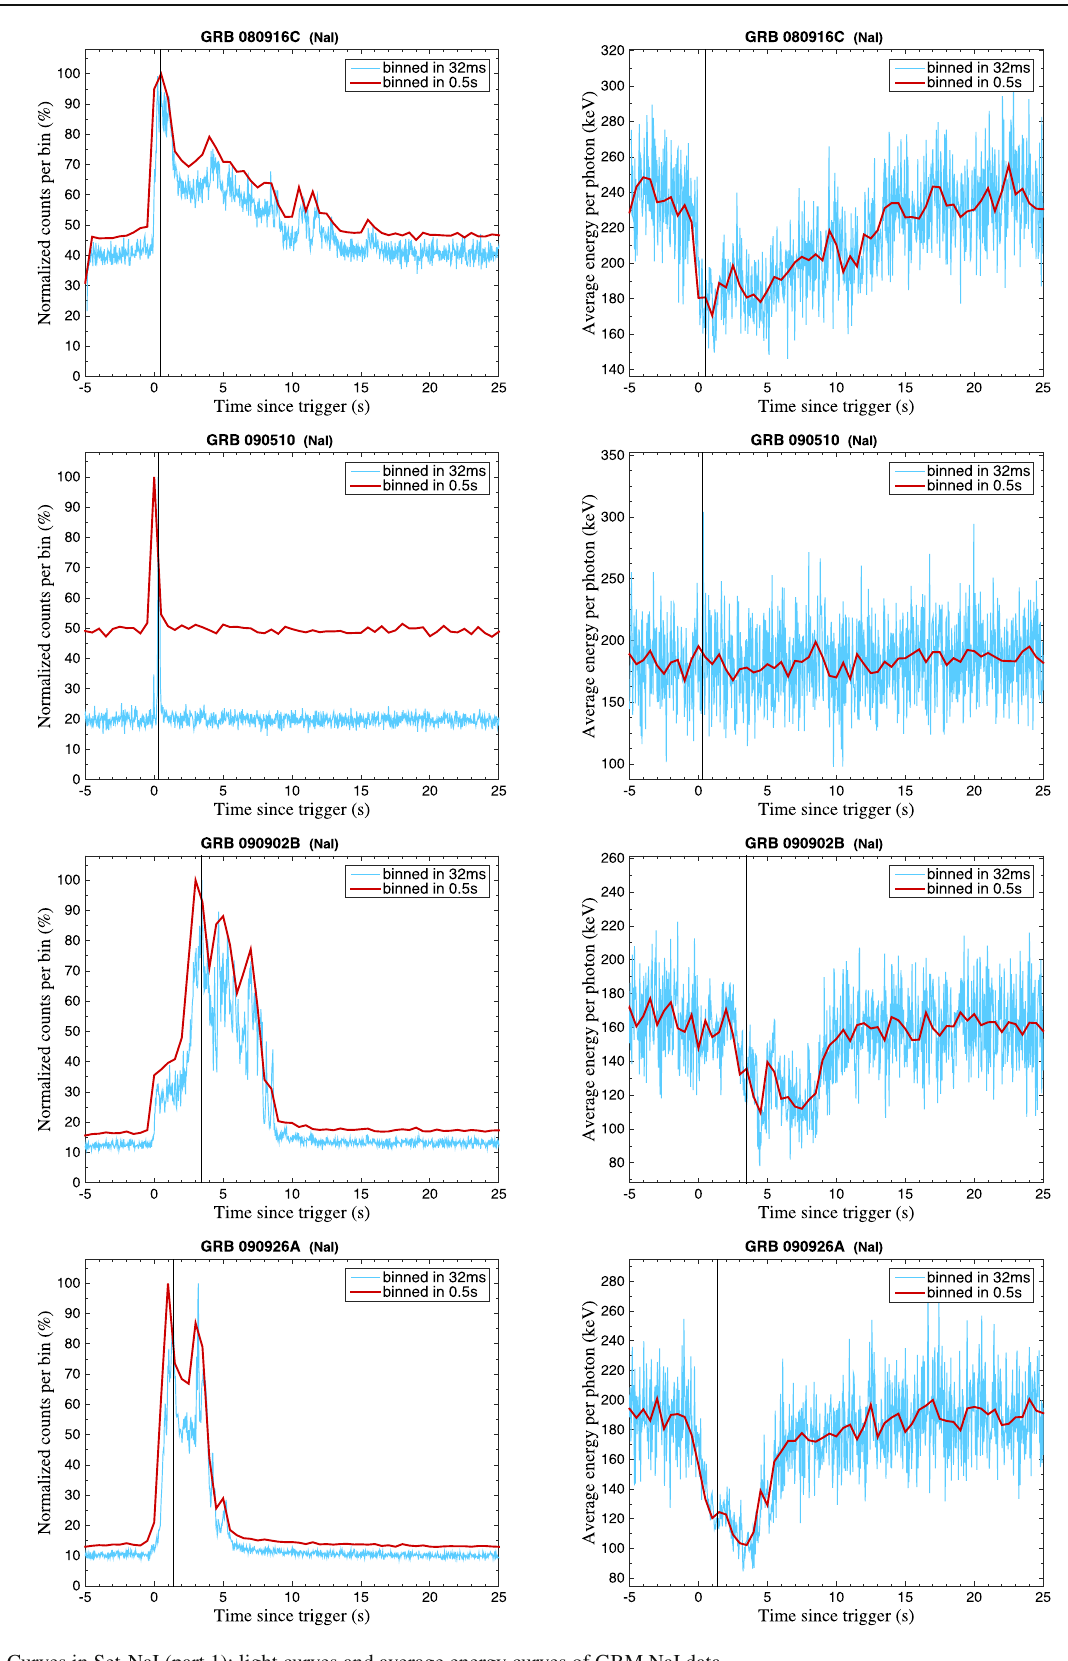
Fig. 17 Curves in Set-NaI (part 1): light curves and average energy curves of GBM NaI